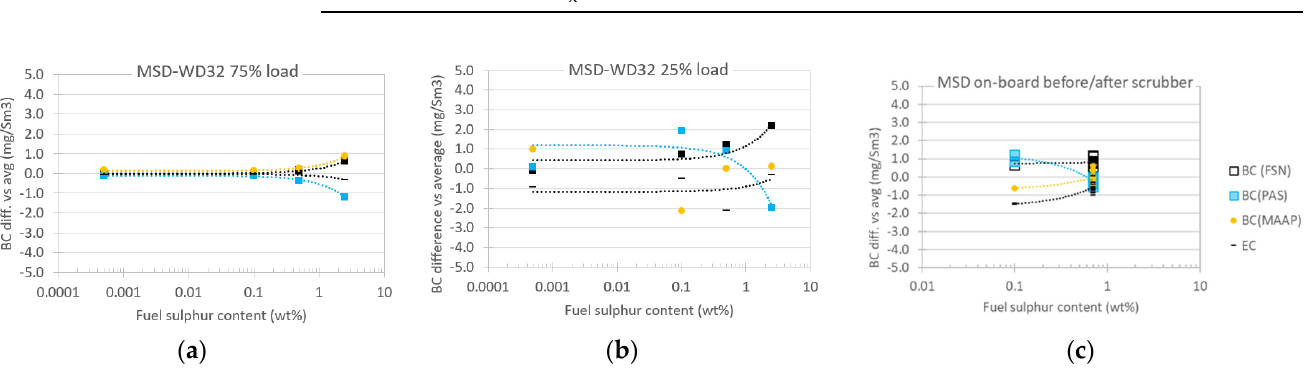
Figure A2. Differences in the BC concentrations obtained with different instruments compared with averages as a function of fuel sulphur content. MSD engines ( a ) at 75% engine load, campaign A, ( b ) at 25% engine load, campaign A, and ( c ) on-board measurements before and after scrubber in campaign B.